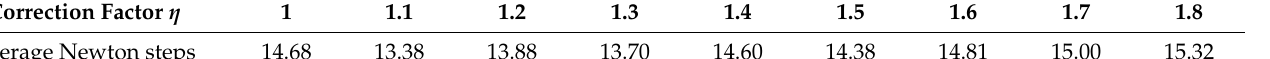
Table 5. Average Newton iterative steps with different correction factors.